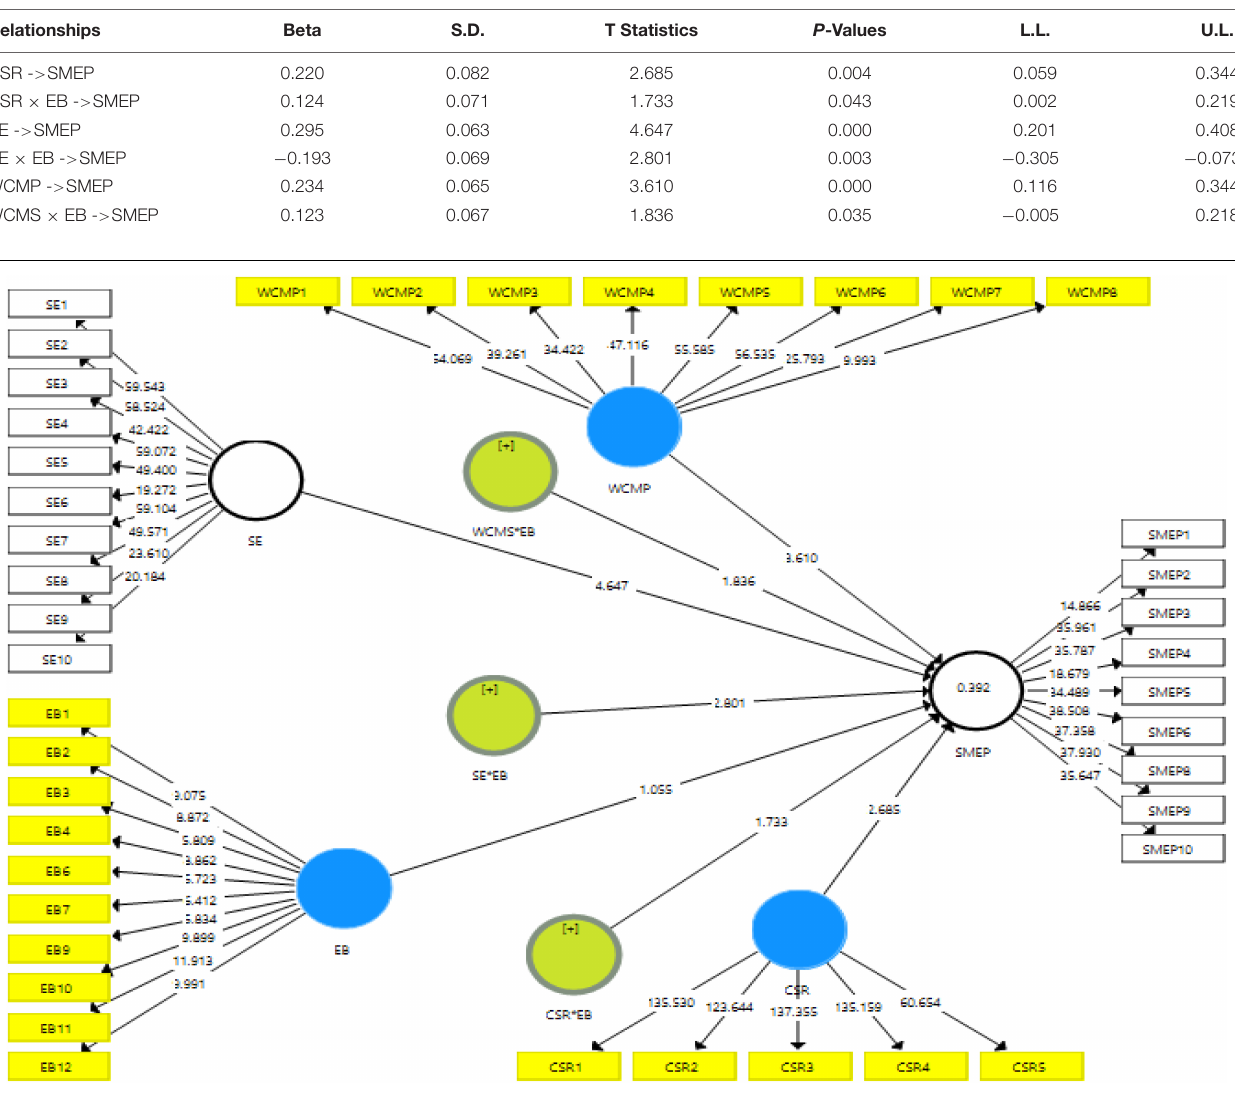
FIGURE 4 | Structural model